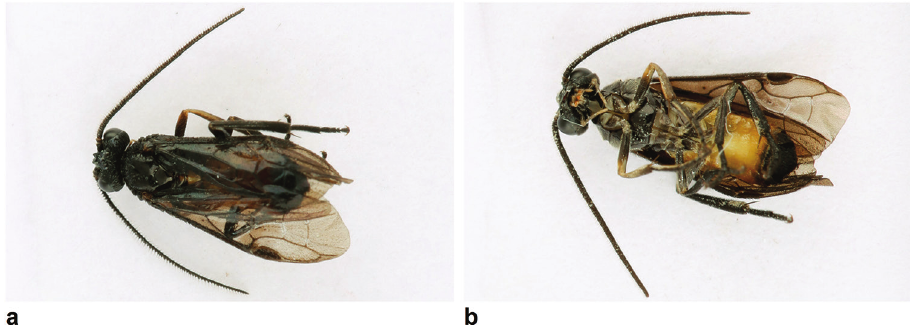
Figure 5. Scobina inculta , male (P4215.E), body length 6.5 mm. a Dorsal view b ventral view.